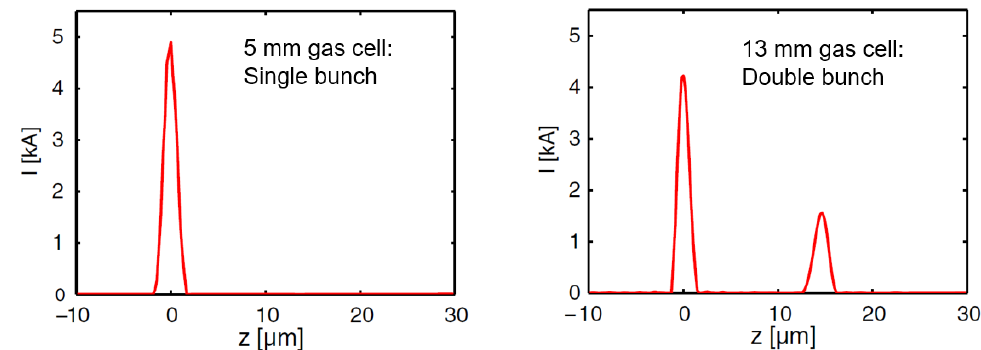
Figure 3. Single and double electron bunches produced from LWFA due to dephasing and a regime change from LWFA to PWFA, measured via coherent transition radiation (figure adapted from